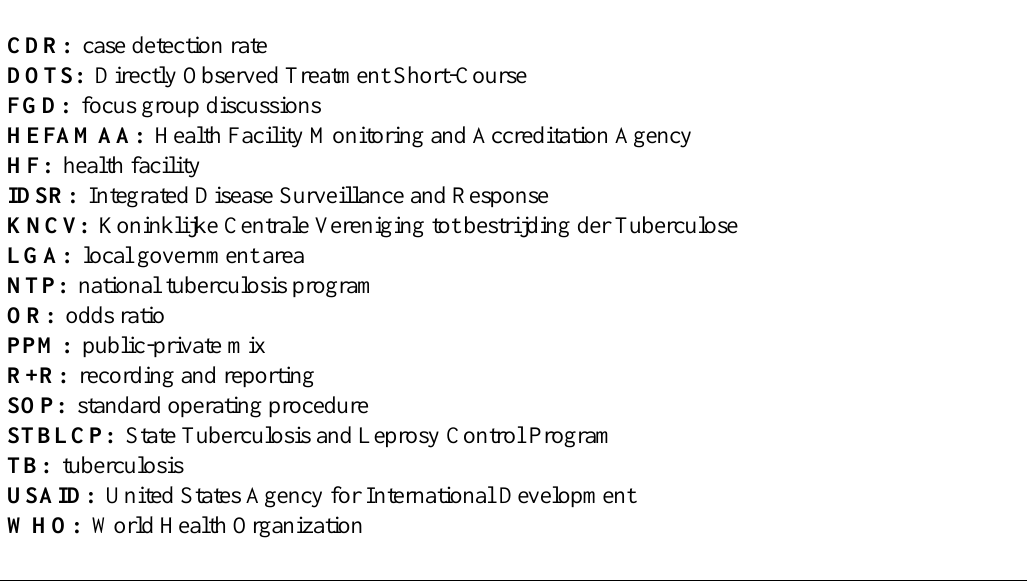
CDR: case detection rate DOTS: Directly Observed Treatment Short-Course FGD: focus group discussions